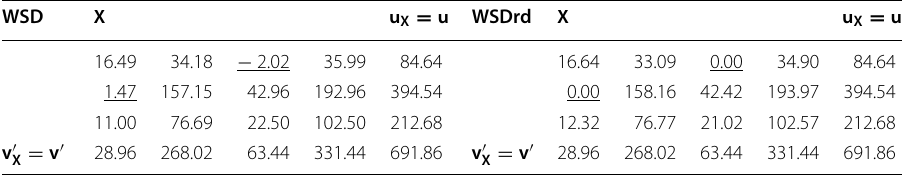
With the same location of underlined matrix elements as in Table 6